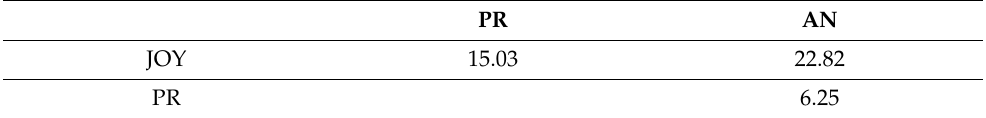
Table 6. Chi-square difference results of the scale (the 1st wave): The Chi-square differences of the items all exceeded 3.84 showing that the discriminative validity fell in an acceptable